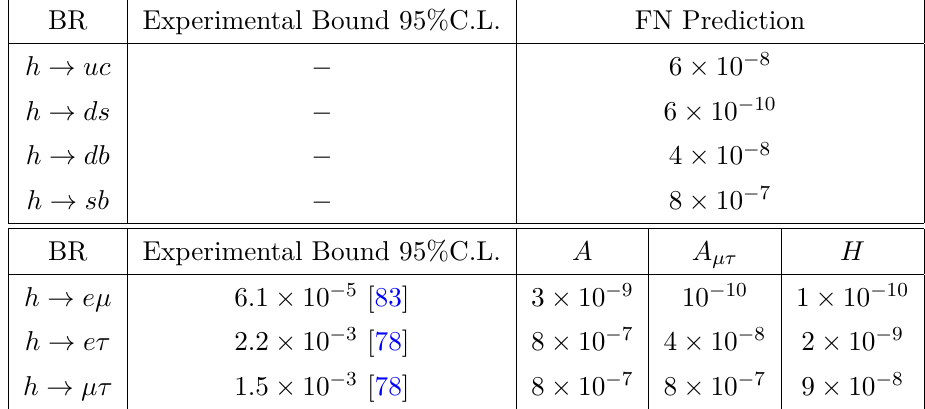
Table 12 . Branching ratios for the flavour changing Higgs decays. In the second column we report the experimental upper bounds when available, while in the other columns the FN predictions, specifying the leptonic FN realisation. The cut-off scales are fixed to Λ q = 1 TeV and Λ ‘ = 4 TeV and all the O (1) parameters are taken equal to 1